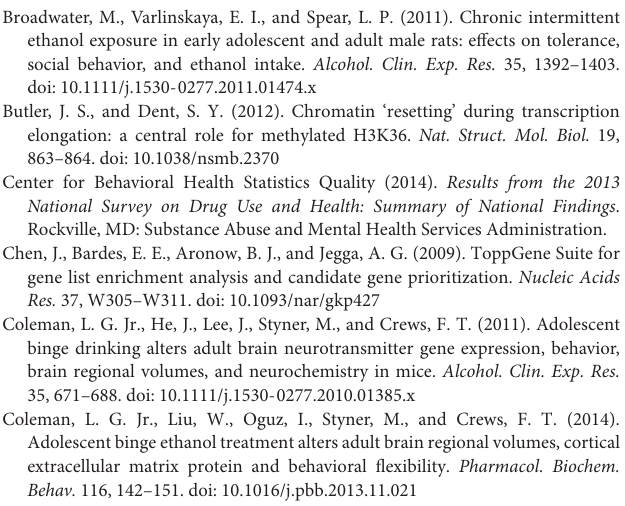
FIGURE S1 | Novel gene networks altered by binge ethanol in adolescent mice. Two novel gene networks generated by Ingenuity Pathway Analysis identified genes involved in histone methylation. The table reflects genes in the Gene Ontology analysis, GO: 0032454 histone demethylase activity (H3-K9 specific)